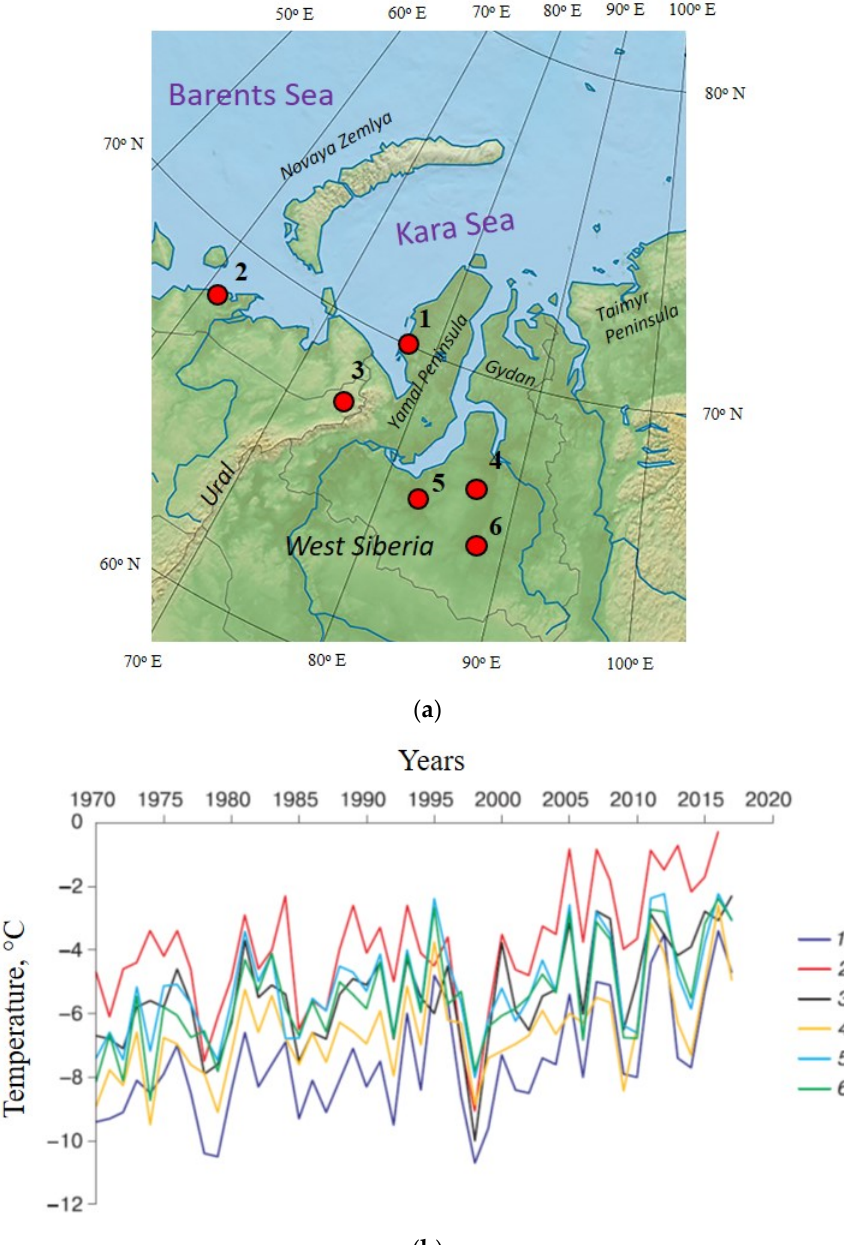
Figure 5. Geocryological station location in the western segment of the Russian Arctic ( a ) and time- dependent changes in air temperature at nearby meteorological stations ( b ): 1 = Marre–Sale; 2 = Cape Konstantinovsky; 3 = Vorkuta; 4 = Novy Urengoi; 5 = Nadym; 6 = Tarko–Sale, after Vasiliev et al. [82].